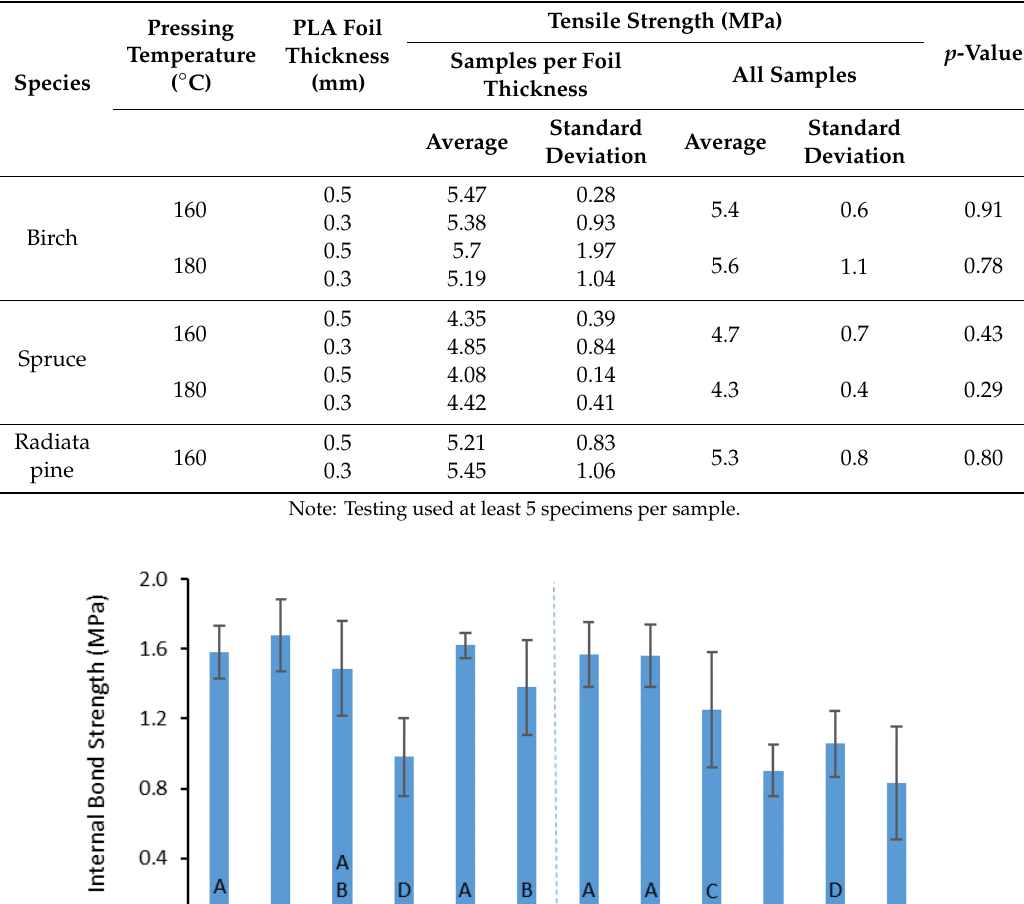
Table 3. Tensile strength values for samples formed with di ff erent amorphous PLA foil thickness compared with all samples produced in this study.